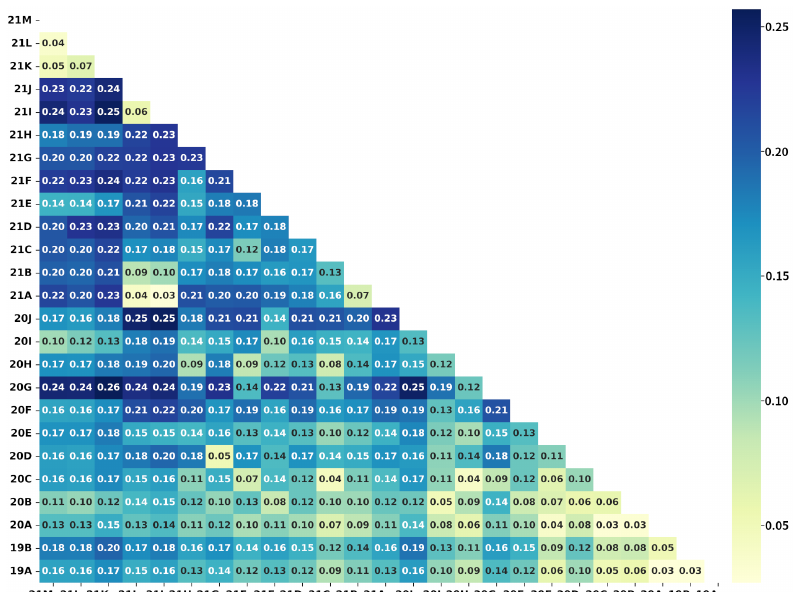
Figure 4. The difference matrix D of the Nextstrain clades. Each element in the matrix represents the difference between the corresponding two Nextstrain clades, and the dark color represents a larger